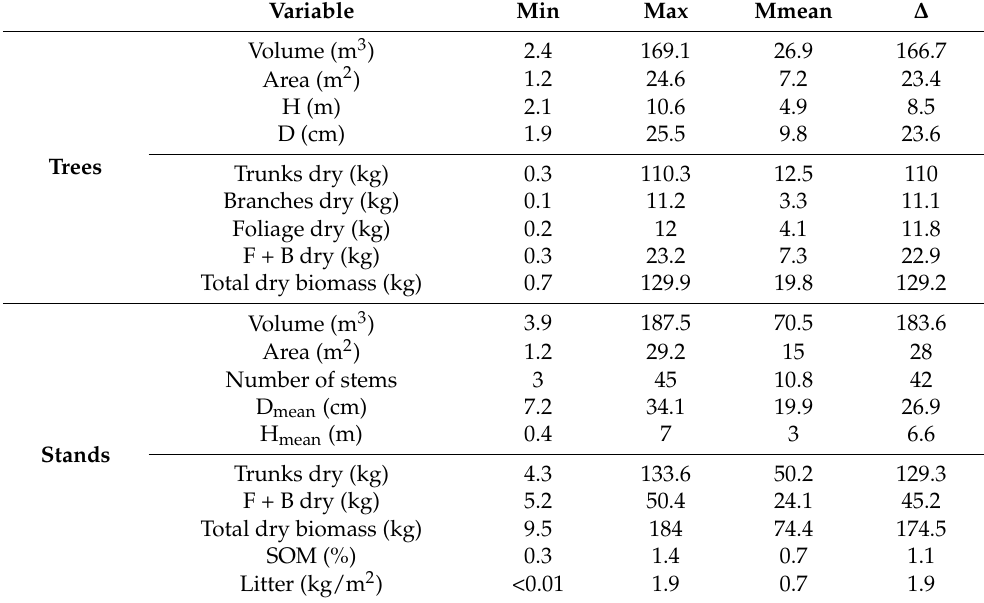
Table 1. Allometric and biomass related variables for single Acacia longifolia trees and whole stands (25 m 2 clear cut quadrat). H = height; D = diameter at soil height; D mean = calculated from all D per plot; H mean = predicted from all pixels per plot (mean: 52,837 pixel per plot); SOM = soil organic matter; F + B = combined foliage and branches; n = 11 for stands, n = 37 for singular trees; ∆ = min-max difference (range). Variable Min Max Mmean ∆ Volume (m 3 ) 2.4